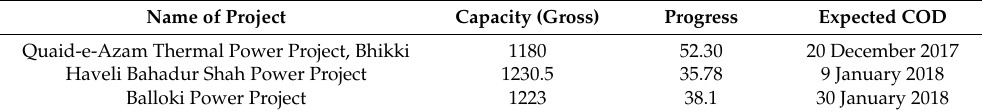
Table 6. New Regasified Liquefied Natural Gas (RLNG)-based projects under development in Pakistan.